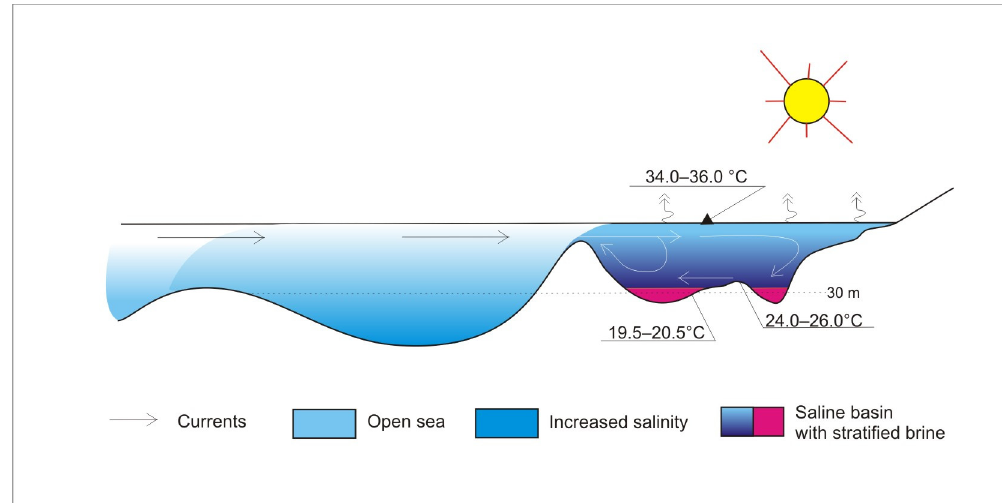
Figure 6. A model of the Badenian saline basin with a pronounced thermocline at depths of about 30 m.